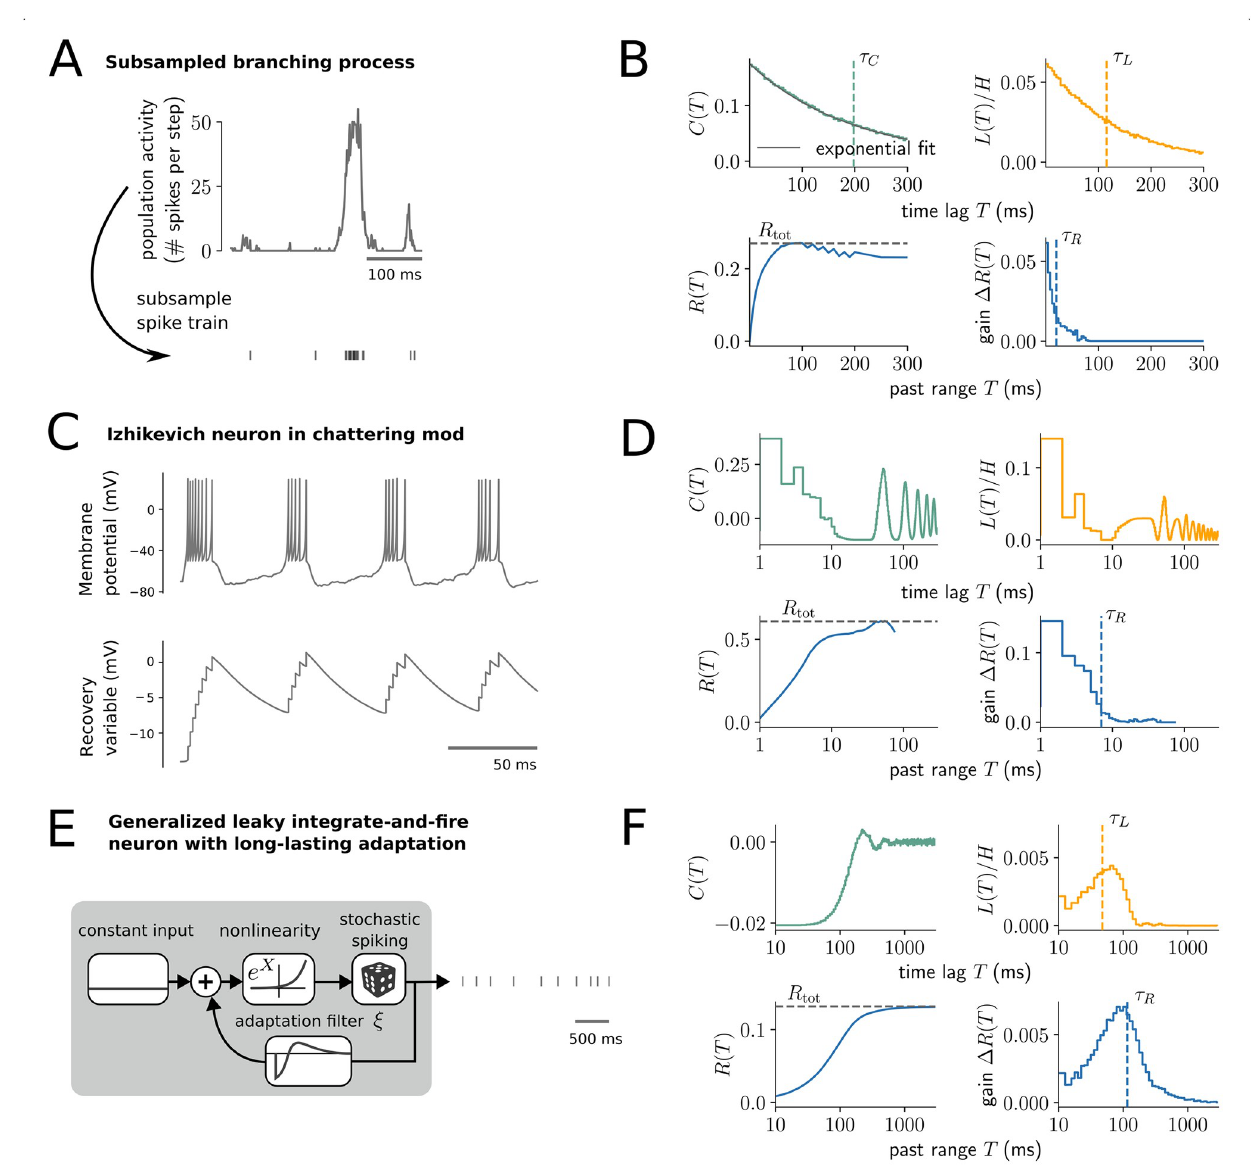
Fig 4. History dependence dismisses redundant past dependencies and captures synergistic effects. (A,B) Analysis of a subsampled branching process. (A) The population activity was simulated as a branching process ( m = 0.98) and subsampled to yield the spike train of a single neuron (Materials and methods). (B) Autocorrelation C ( T ) and lagged mutual information L ( T ) include redundant dependencies and decay much slower than the gain Δ R ( T ), with much longer timescales (vertical dashed lines). (C,D) Analysis of an Izhikevich neuron in chattering mode with constant input and small voltage fluctuations. The neuron fires in regular bursts of activity. (D) Time-lagged measures C ( T ) and L ( T ) measure both, intra- ( T < 10 ms) and inter-burst ( T > 10 ms) dependencies, which decay very slowly due to regularity of the firing. The gain Δ R ( T ) reflects that most spiking can already be predicted from intra-burst dependencies, whereas inter-burst dependencies are highly redundant. In this case, only Δ R ( T ) yields a sensible time scale (blue dashed line). (E, F) Analysis of a generalized leaky integrate-and-fire neuron with long-lasting adaptation filter ξ [3, 43] and constant input. (F) Here, Δ R ( T ) decays slower to zero than the autocorrelation C ( T ), and is higher than L ( T ) for long T . Therefore, the dependence on past spikes is stronger when taking more-recent past spikes into account ( Δ R ( T )), as when considering them independently ( L ( T )). Due to these synergistic past dependencies, Δ R ( T ) is the only measure that captures the long-range nature of the spike